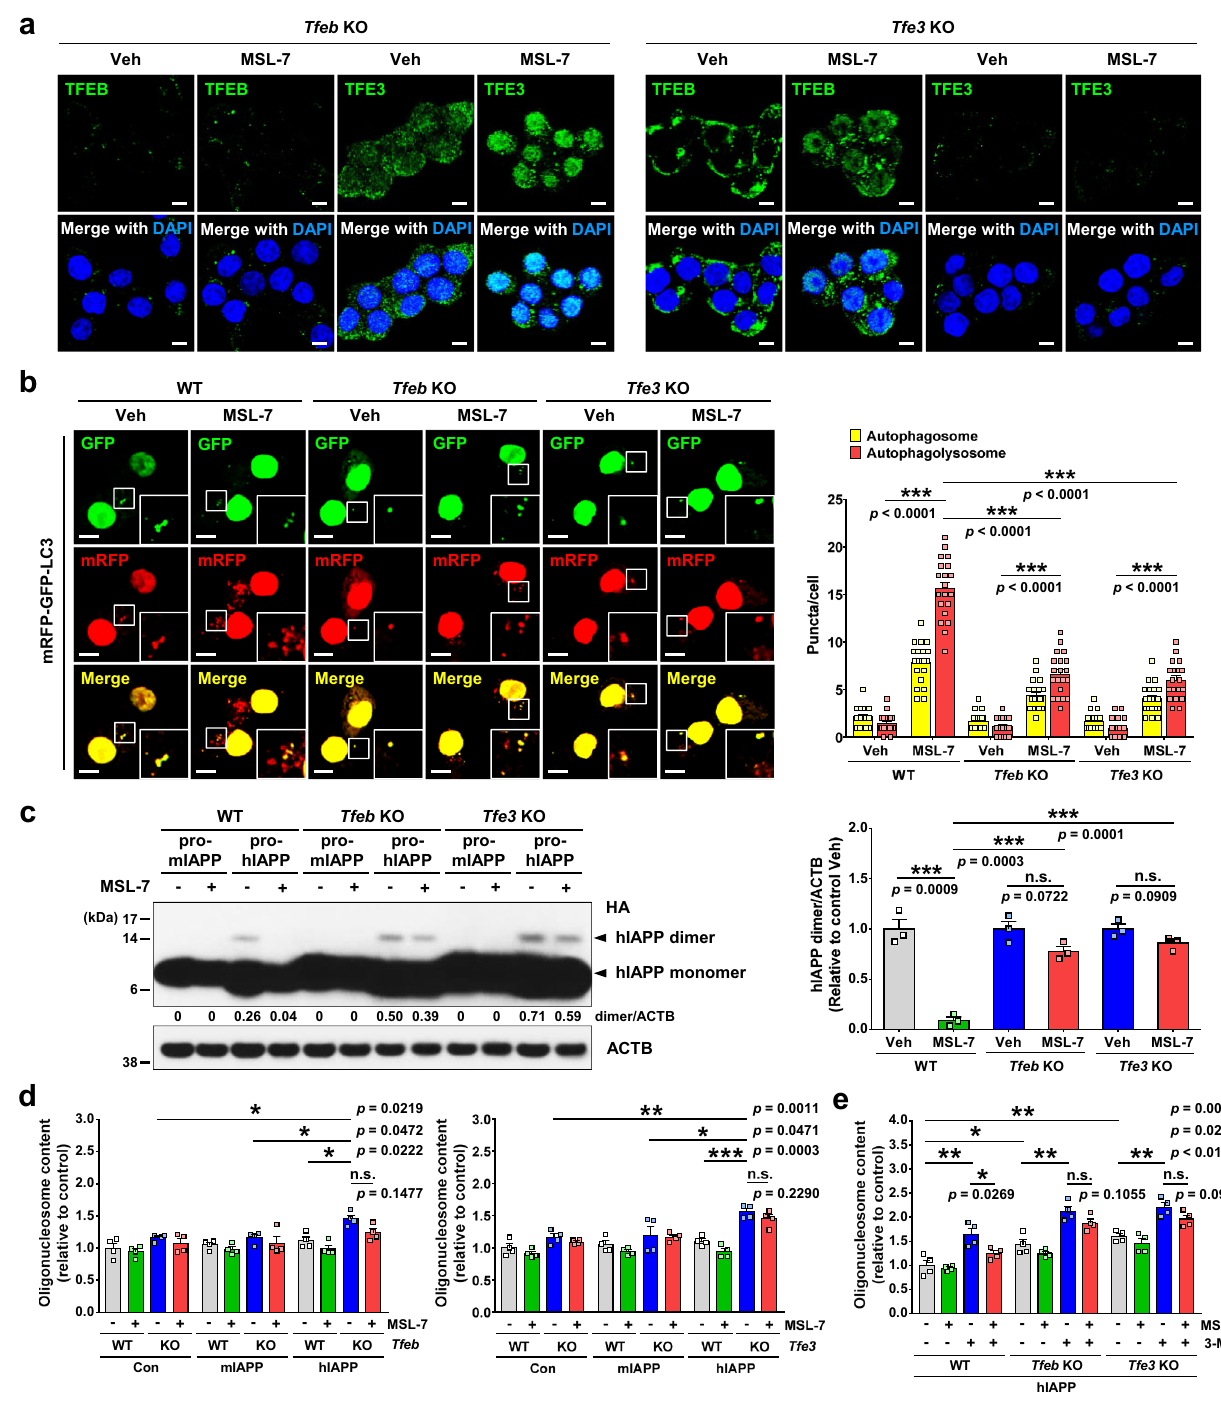
prepro-hIAPP transfection in the presence of 3-MA was also not signi fi cantly reduced by MSL-7 (compare 7th and 8th or 11th and 12th bars from the left of Fig. 4e), which is different from a signi fi cant decrease of prepro-hIAPP -transfected control INS-1 cell apoptosis in the presence of 3-MA by MSL-7 (compare 3rd and 4th bars from the left of Fig. 4e; see also Fig. 2b) and is probably due to reduced MSL-7-mediated autophagy in Tfeb -KO or Tfe3 -KO INS-1 cells. Residual effect of MSL-7 in Tfeb- KO or Tfe3 -KO INS-1 cells such as induction of low-level autophagy (Fig. 4b) and small increases of autophagy gene or lysosomal gene